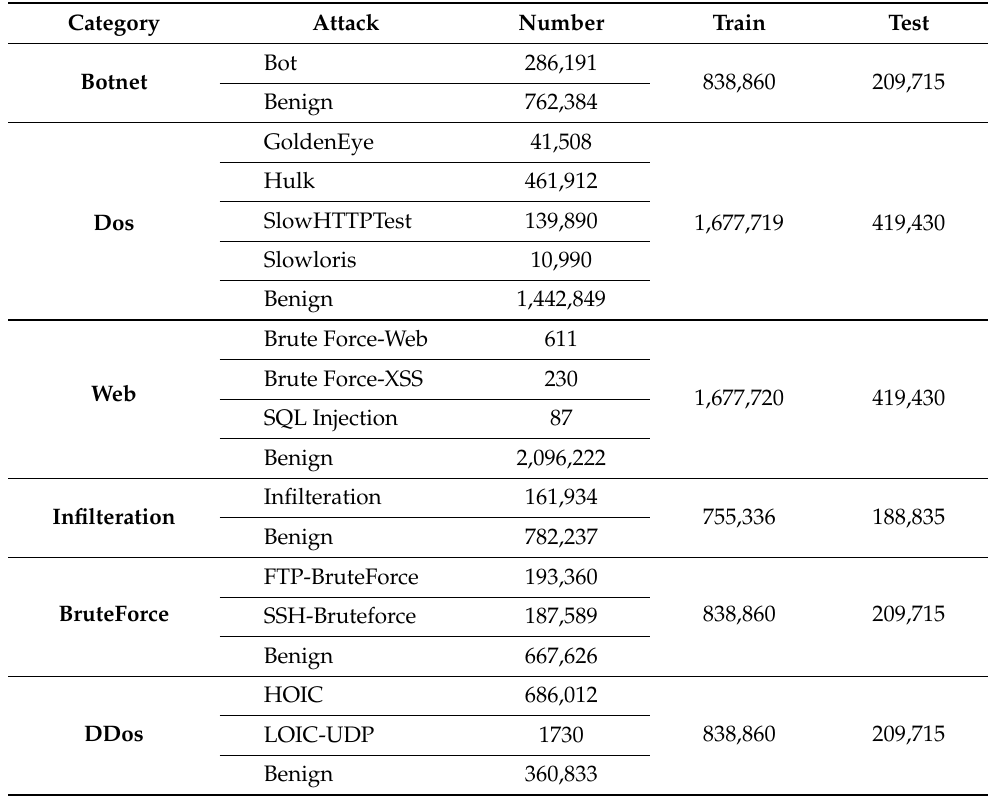
Table 1. Table of attack